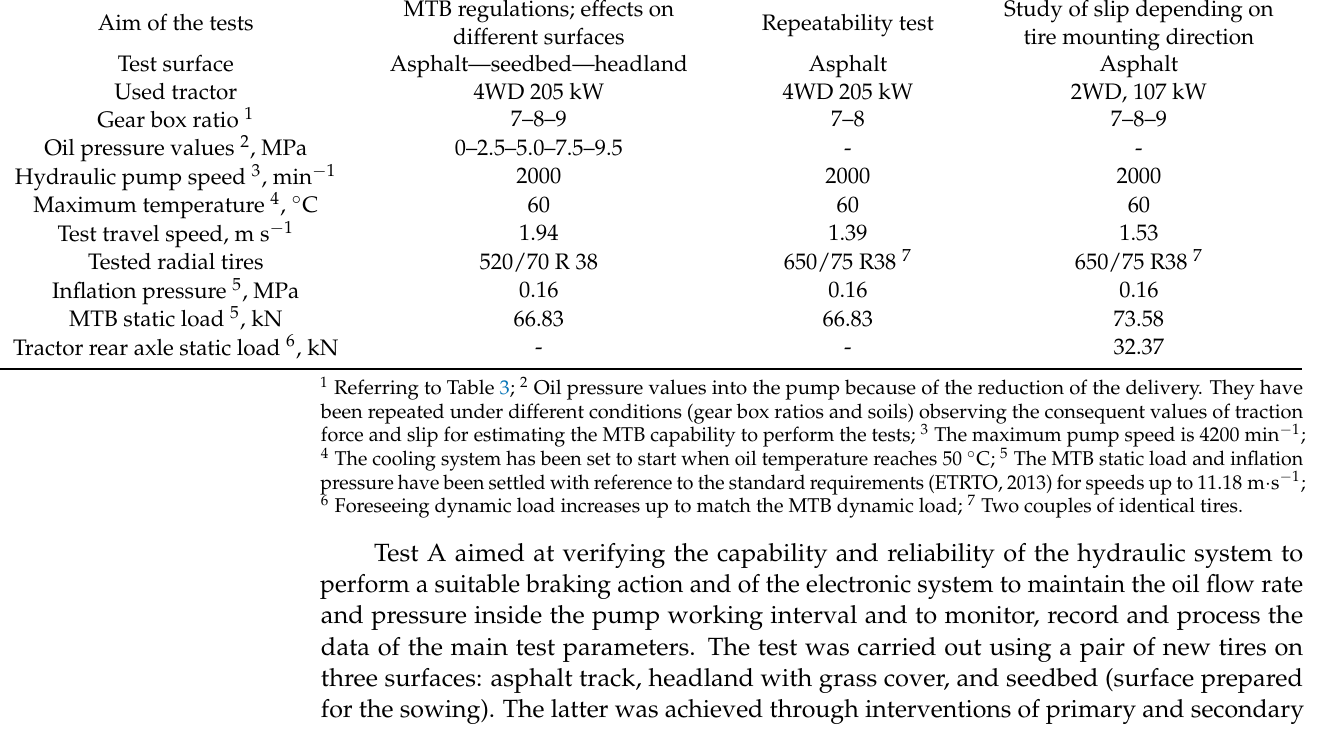
Table 4. Test Table 4. Test conditions.